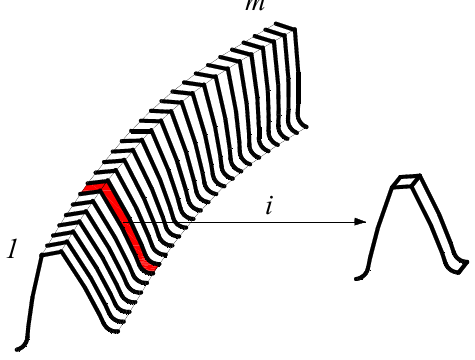
Figure 9. Spur gear slices of helical gear.